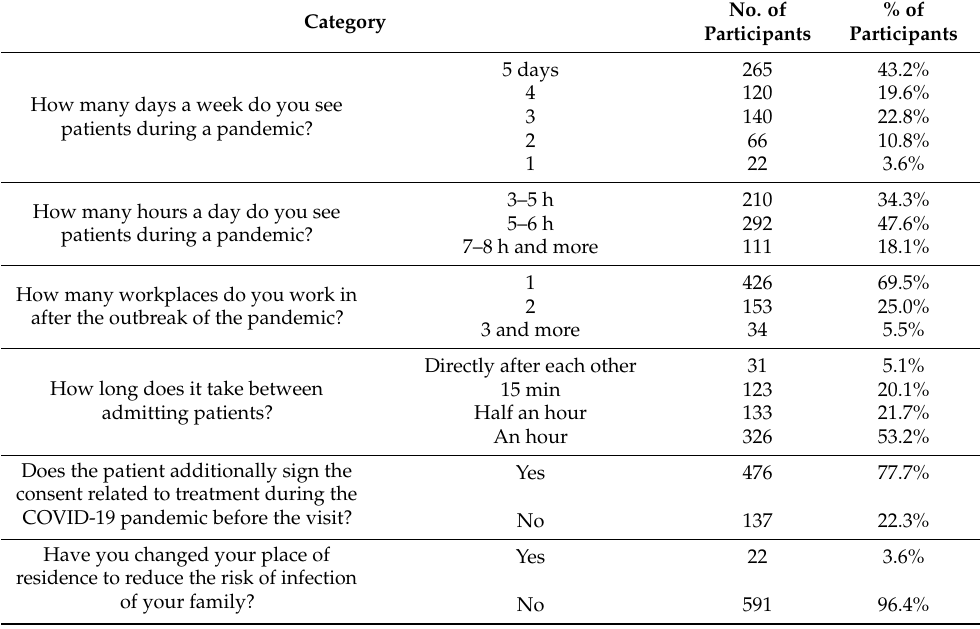
Table 2. Selected answers to questions about working in the office during a pandemic.